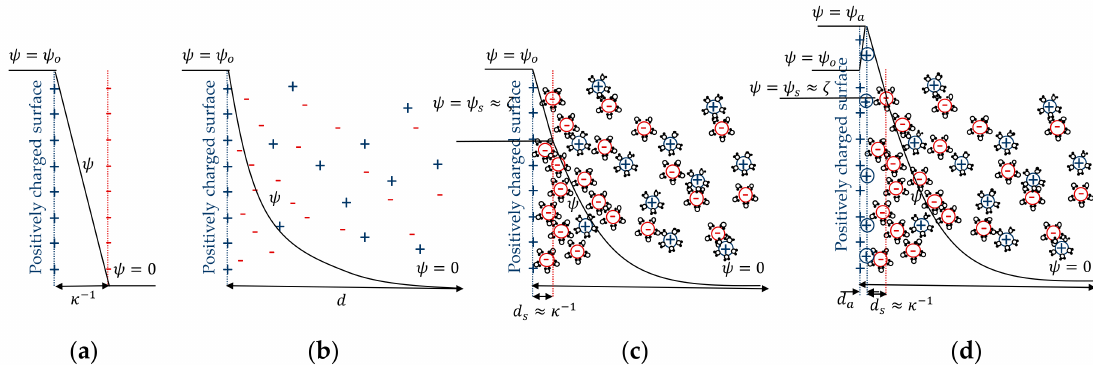
Figure 2. Models of the electrical double layer: ( a ) Helmholtz, ( b ) Gouy and Chapman, ( c ) Stern and Grahame, and ( d ) Stern and Grahame with specific adsorption of